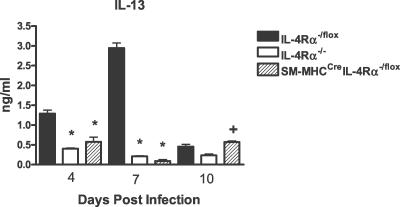
Intestinal IL-13 Levels Are Disrupted in SM-MHCCreIL-4Rα−/lox MiceIntestinal supernatants were analyzed for IL-13 cytokine production by ELISA as described in Materials and Methods. *Significant difference (p < 0.05) from IL-4Rα−/lox mice; +significant difference from day 10 PI IL-4Rα−/− mice. Data are representative of three repeated experiments.